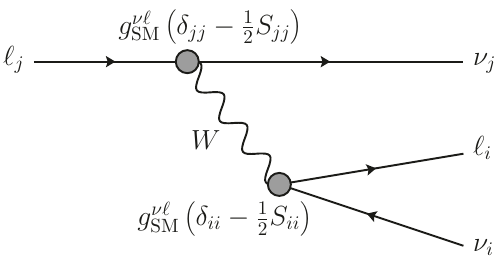
is the SM W‘ν SM